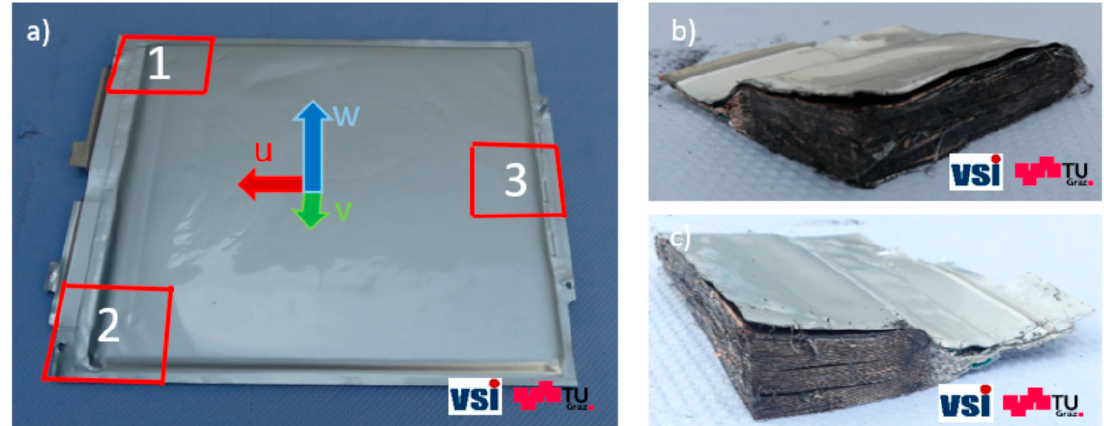
Figure 3. ( a ) Sample generation locations for the investigation of the stacked layer structure. #1—anode tab, #2—cathode tab, #3—middle of the side opposite to the tabs. ( b ) Sample generated at position 1; ( c ) sample generated at position 2.